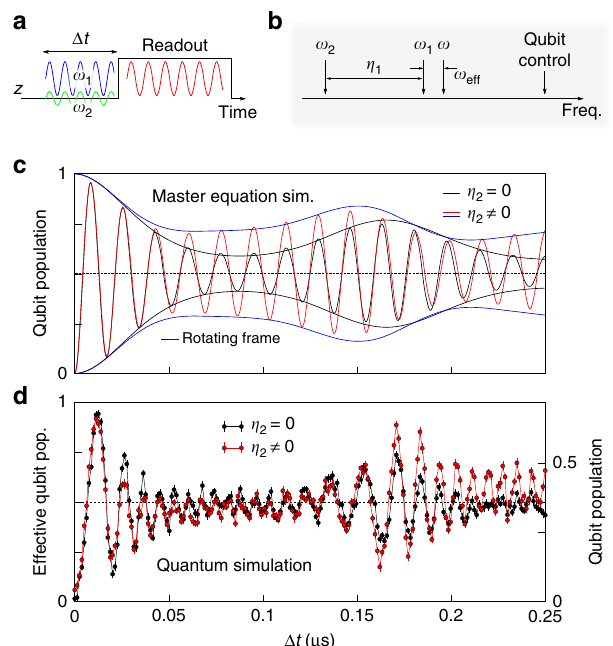
Fig. 4 Simulation of the full quantum Rabi model. a Schematic pulse sequence used in the experiment. b Overview on the relative frequencies of the bosonic mode and the applied drives. The constraint η 1 = ω 1 − ω 2 is sketched. c Master equation simulations for vanishing qubit term η 2 = 0 ( black ) and with non-vanishing qubit term η 2 > 0 ( red ). The blue line corresponds to the classical simulation for η 2 /2 π = 3 MHz. d Quantum simulation for equal parameters. The dispersive shift of the readout resonator induced by the bosonic mode is subtracted based on classically simulated data. Error bars denote a statistical s.d. as detailed in the